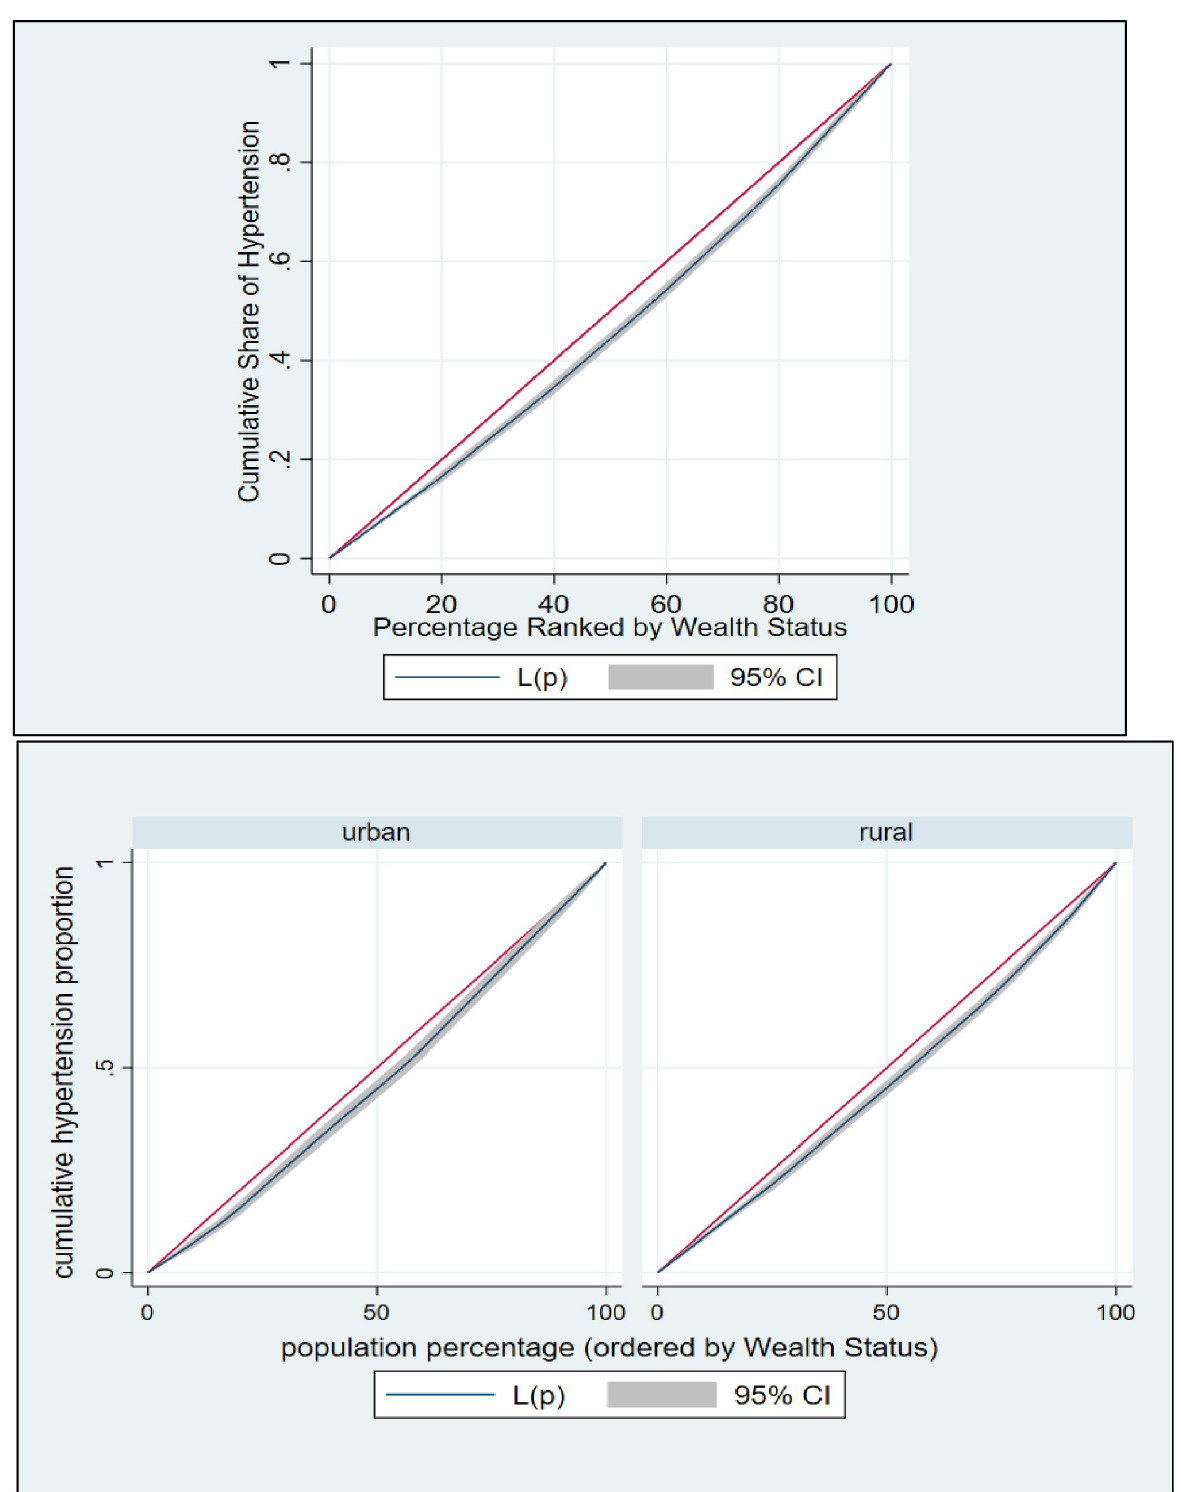
Fig 2. Concentration curve for hypertension over wealth status.